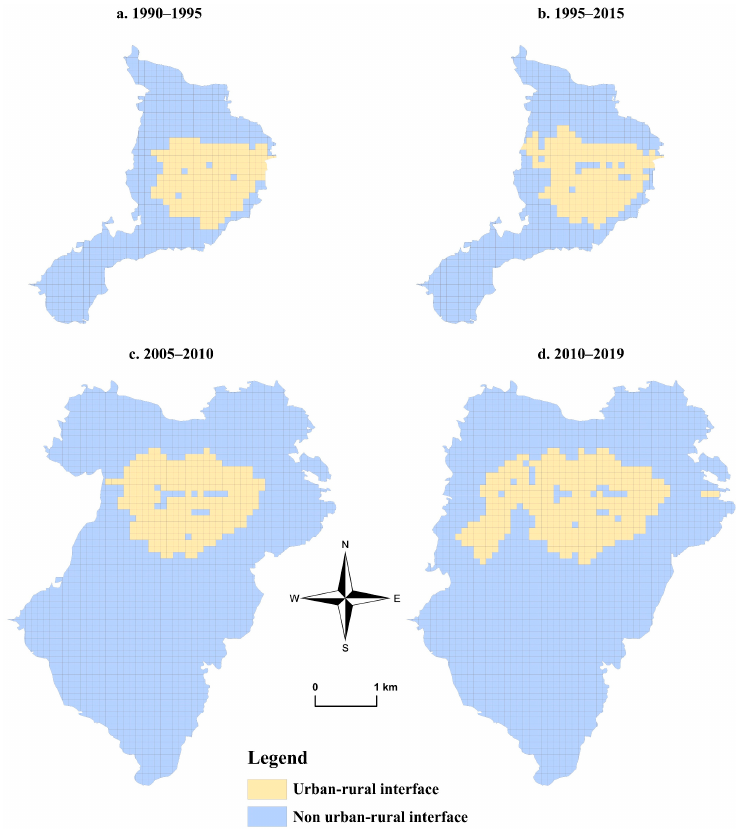
Figure 6. Spatial distribution of Zhulin’s urban–rural interface. Reference system GCS Xian 1980.